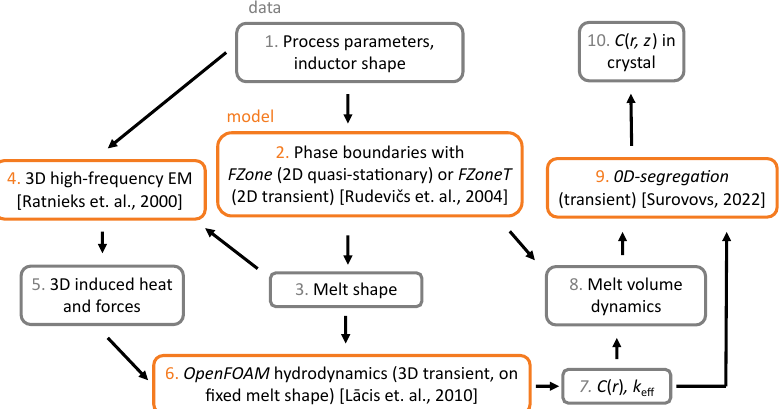
Figure 3. The overall scheme of the used numerical models ( orange boxes ) and the data that is being exchanged between them ( grey boxes